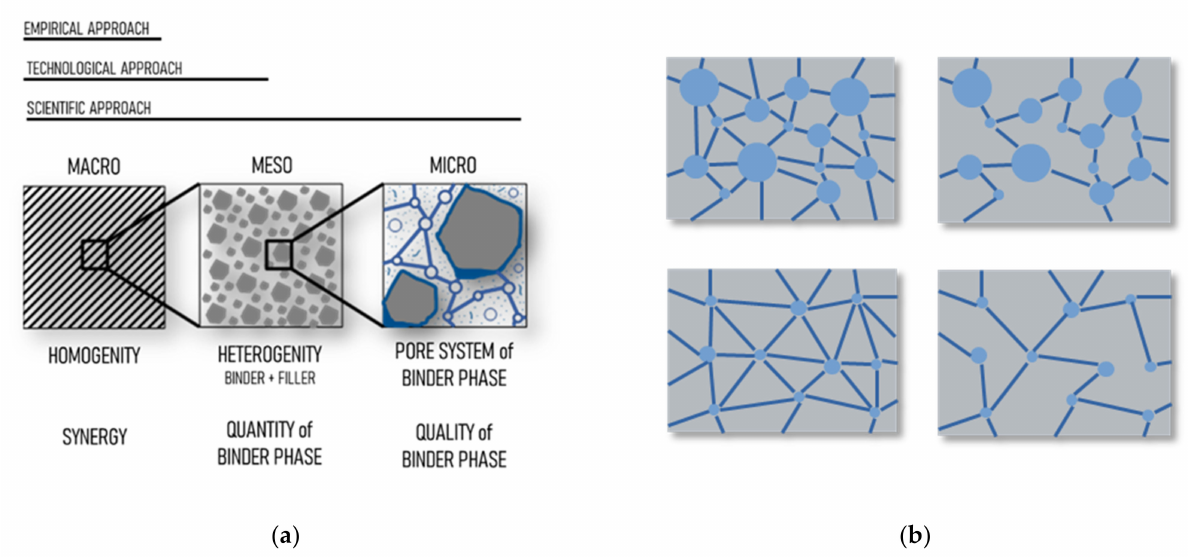
Figure 1. Concept of cement composite designing: ( a ) Multi-scale approach; ( b ) Variations of an open pore system in a cement